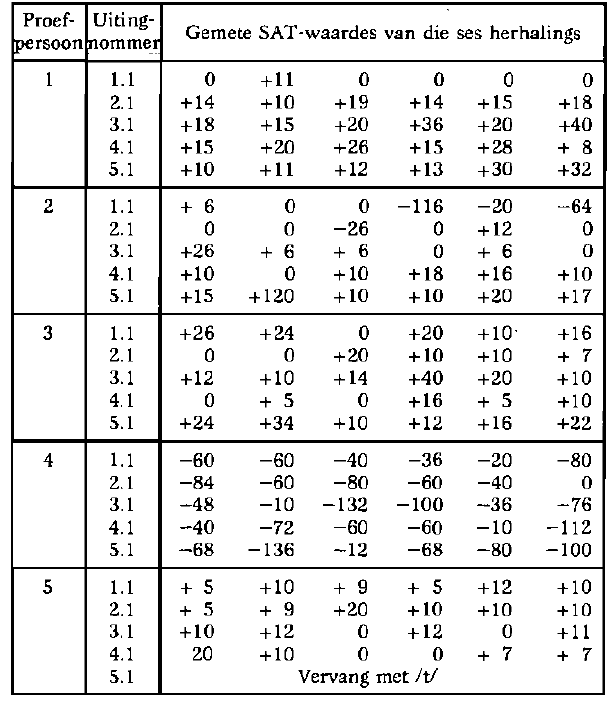
Tabel 2: Die gemete SAT-waardes van die ses herhalings van eenhede in die verskillende klankstruk- Uiting- Proef- persoon